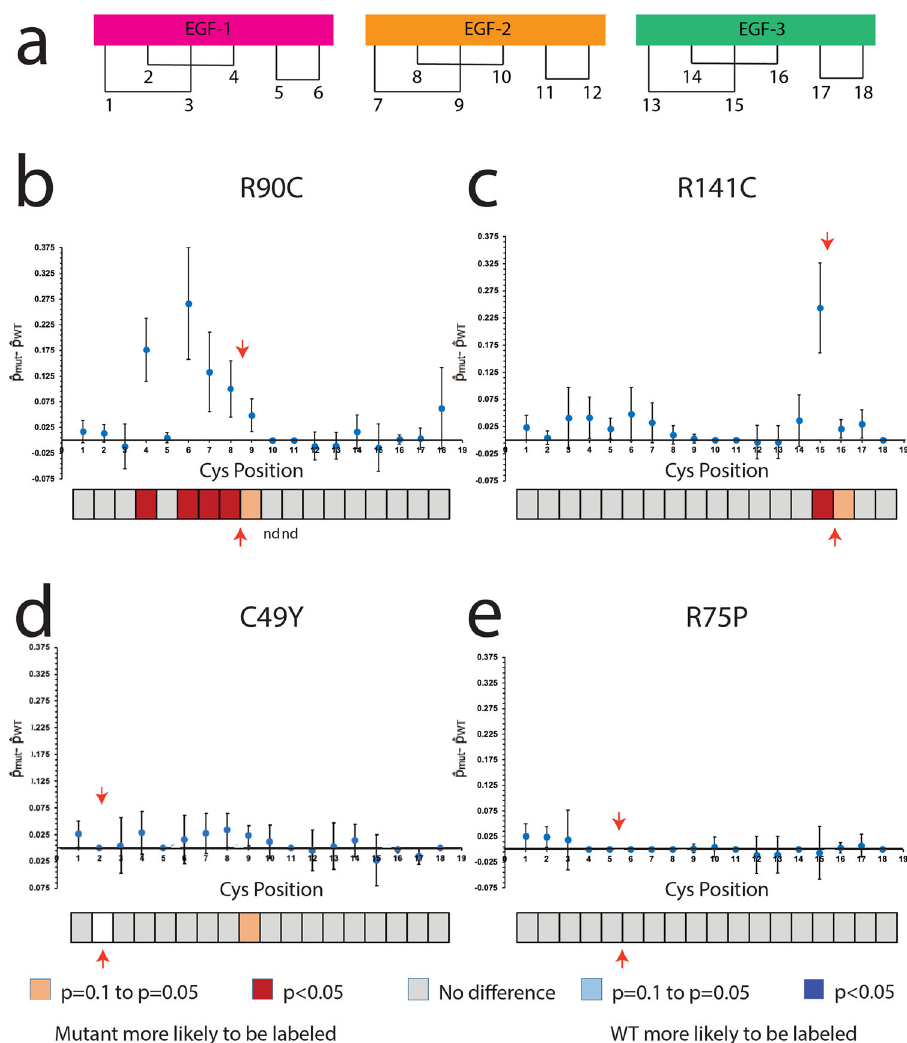
Fig. 2 Select CADASIL mutant proteins have increased probability of having free thiols accessible for NEM labeling compared to WT protein. a Demonstrates a schematic of the fi rst 3 EGF like repeats with the predicted disul fi de pairing. All cysteines examined are labeled from 1 to 18. Cysteines that are only present in mutant proteins are not shown but can be found in Fig. S1. R90C mutant protein demonstrated a signi fi cantly increased probability of being labeled with NEM at cysteine positions 4, 6, 7, and 8 ( p < 0.05; ( b )). The R141C mutant protein had signi fi cantly increased probabilities of being labeled with NEM at position 15 ( p < 0.05) and trended toward increased NEM labeling at position 16 ( c ). The C49Y mutant did not signi fi cantly differ in NEM labeling probabilities from WT protein, but the mutant protein trended towards having an increased probability of NEM labeling at cysteine position 9 ( d ). The R75P mutant protein did not differ signi fi cantly from WT protein in NEM labeling at any cysteine position ( e ). The bar below each panel represents statistical signi fi cance at each cysteine position (box). Locations of each mutation found in the mutant proteins are indicated with a red arrow. Cysteines that were not detected in a sample are denoted with “ nd. ” Experiments were repeated at least six times using distinct samples with similar results. Figure 2 includes data from all replicates performed. Individual data points used for analysis can be found in Fig. S1b –